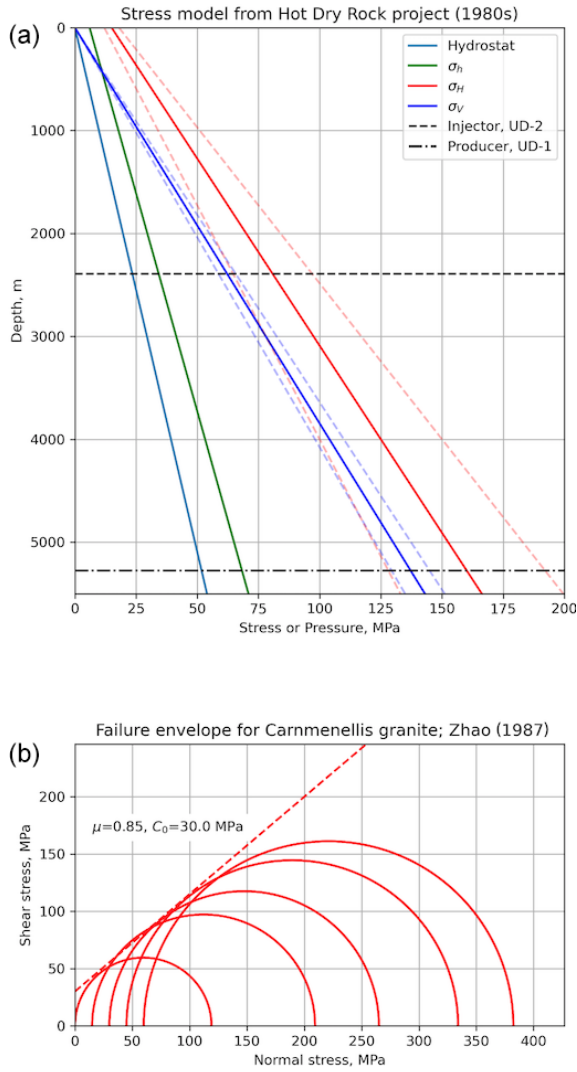
Figure 12. Constraints on input variables for the Porthtowan Fault Zone modelling. (a) Stress–depth plot based on data and equations from the Hot Dry Rock project in the Carnmenellis granite (Batch- elor and Pine, 1986). Dashed lines show minimum and maximum values for each stress. Also shown are the depths of the two wells in the pilot project at United Downs. (b) Mohr diagram showing data from laboratory mechanical tests of Zhao (1987) for brittle failure of Carnmenellis granite at 200 ◦ C. The estimated Mohr– Coulomb failure envelope (dashed red line) is defined by µ = 0 . 85, C 0 =